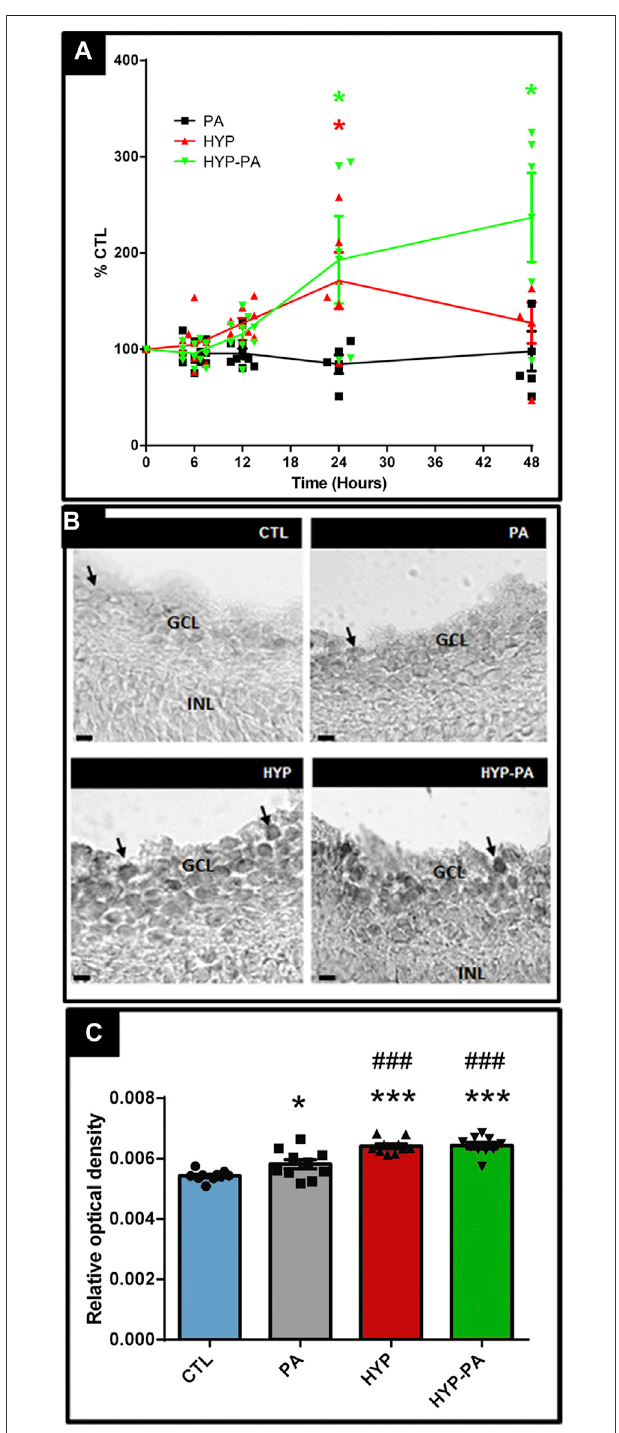
FIGURE 5 | RBM3 expression is elevated by hypothermia. (A) : Relative RBM3 mRNA expression through time as measured by qRT-PCR. A signi fi cant increment of RBM3 mRNA expression was induced by both cold treatments(HYP andHYP-PA groups) compared toCTLand PAgroups at 24 h after perinatal asphyxia. However, 48 h after asphyxia, RBM3 expression remained signi fi cantly elevated only in the HYP-PA group. All